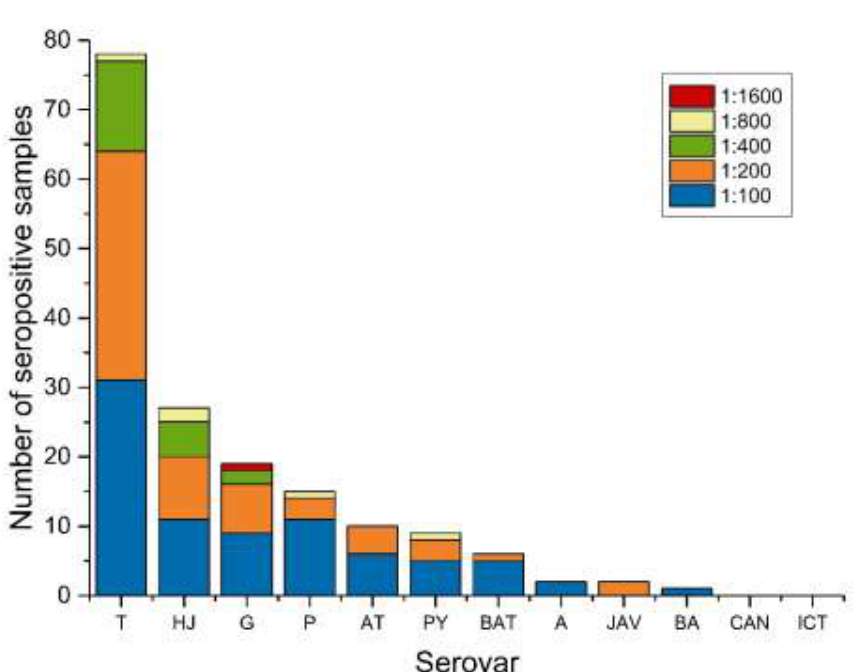
Figure 2. Number of seropositive samples with titers from 1:100 to 1:1600 for each serovar. Seroprevalences of some serovars may be overestimated due to cross-reactivity. Serovars included in the test: L. Tarassovi (T), L. Hardjo (HJ), L. Grippotyphosa (G), L. Pomona (P), L. Autumnalis (AT), L. Pyrogenes (PY), L. Bataviae (BAT), L. Australis (A), L. Javanica (JAV), L. Ballum (BA), L. Canicola (CAN) and L. Icterohaemorrhagiae (ICT).